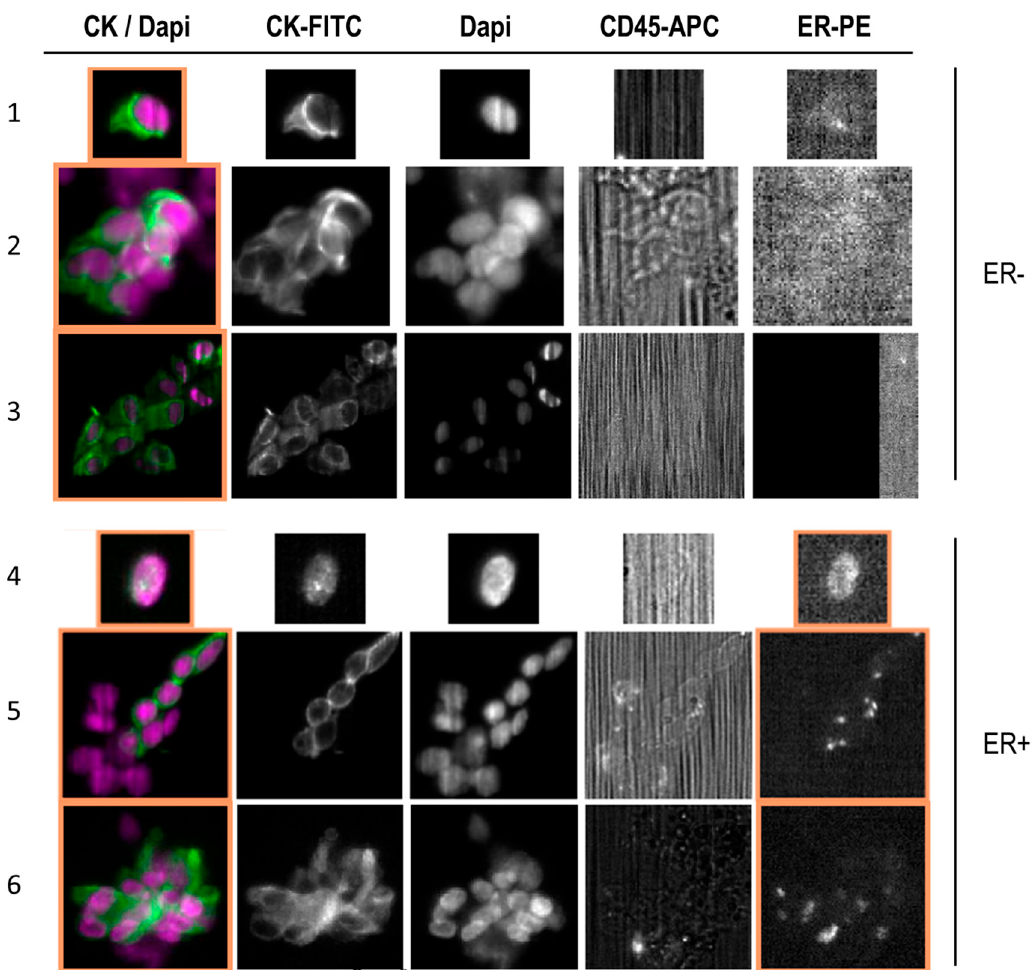
Figure 3. Representative images of circulating endometrial cancer cells detected with the CellSearch ® system in ovarian vein blood samples from patients with early-stage endometrial cancer during surgery . CTCs were identified as EpCAM (+) , CK (+) , DAPI (+) , and CD45 ( − ) cells. In the fourth channel, an antibody against ER was added to characterize CTCs. Individual ER ( − ) CTCs (line 1), clusters of ER ( − ) CTCs (lines 2–3), individual ER (+) CTCs (line 4), and clusters of ER (+) CTCs (lines 5–6) were observed in the ovarian vein blood samples of patients with early-stage en- dometrial cancer. Abbreviations: EpCAM, epithelial cell adhesion molecule; CK, cytokeratin; DAPI, 4 (cid:48) ,6-diamidino-2-phenylindole; FITC, fluorescein isothiocyanate; APC,